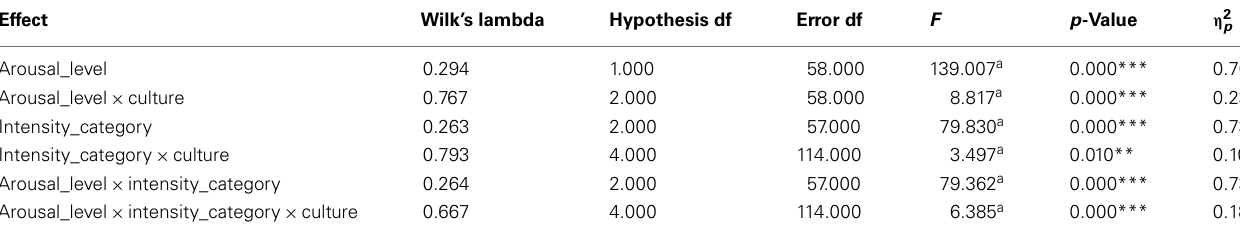
TableA10 | Omnibus MANOVA for categorization difference scores of ipsatized data.